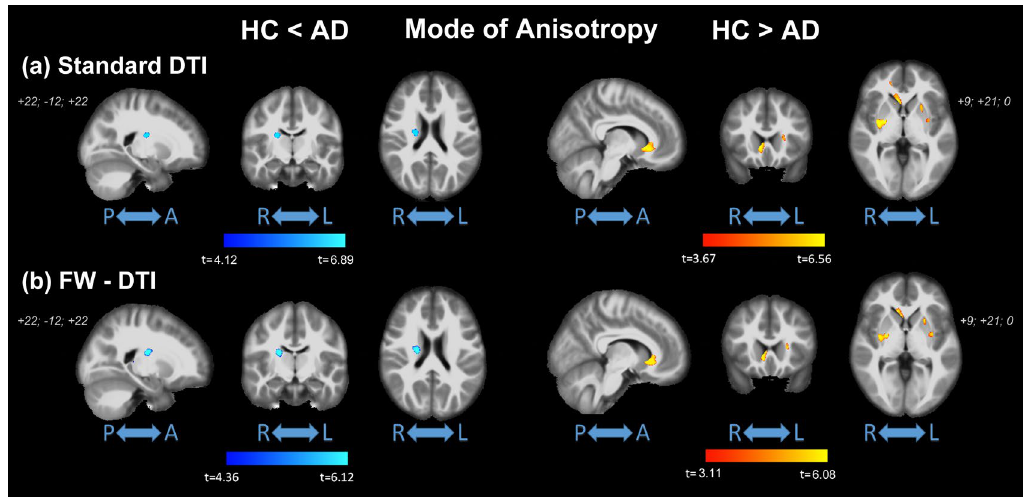
Figure 4. Coronal view of ANCOVA analysis between HC and AD subjects for MA index from ( a ) standard DTI and ( b ) FW-DTI. Left: MA in HC < MA in AD; right: MA in HC > MA in AD. Clusters are reported at a significance threshold of p -value < 0.01 corrected for